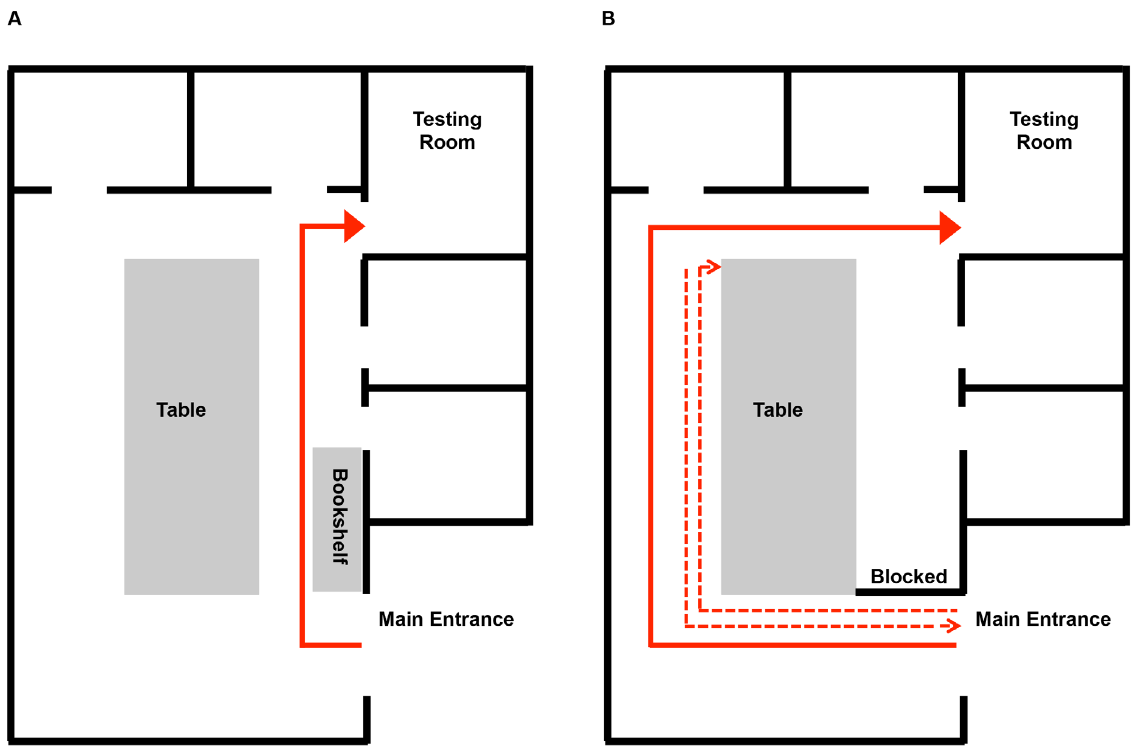
Figure 2. Map of the conference room. The solid arrows indicate the walking path from the door of the conference room to the testing room for the pilot study (A) and in the current experiment (B). In the pilot study, participants walked directly from the main entrance to the testing room. In the present study, participants first walked to the end of the table to retrieve the ‘‘experiment in progress’’ sign. Next, they returned to the main entrance and handed it to the experimenter, who was waiting there. Then they walked from the entrance to the testing room, traversing a longer route around the far end of the table because the shorter route was blocked with a bookshelf. doi:10.1371/journal.pone.0099051.g002 PLOS ONE |